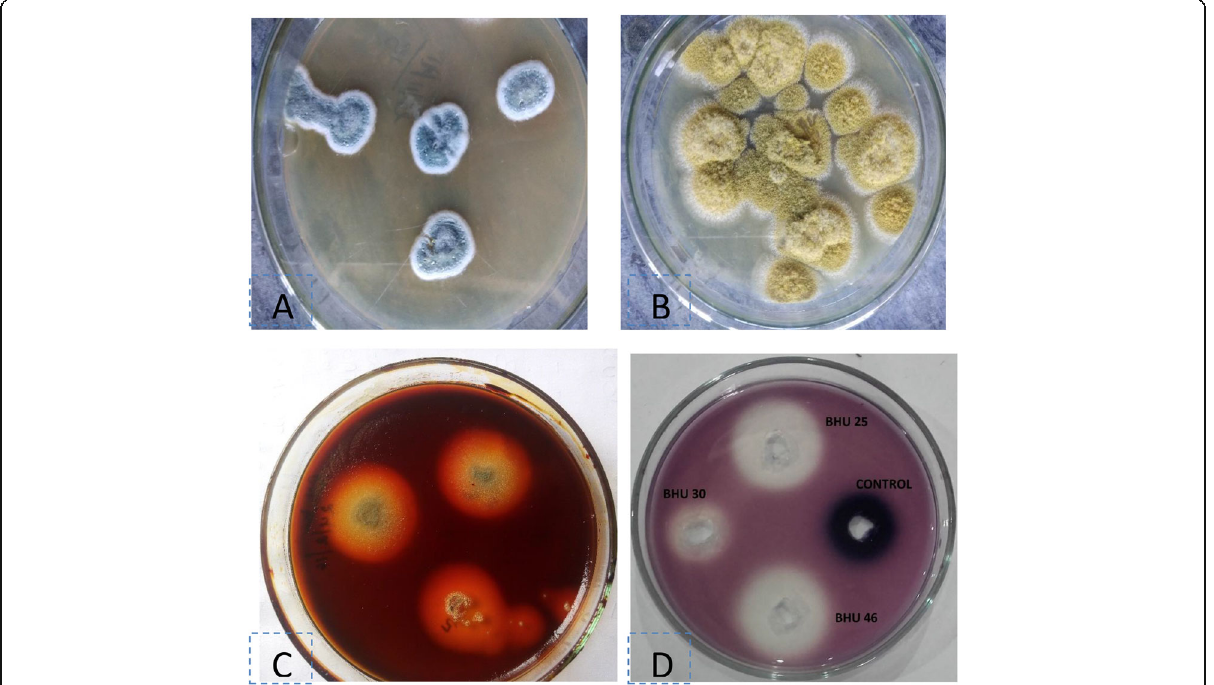
Fig. 3 Colony morphology of isolates a BHU-25-1; b BHU-46, d hydrolysis of pullulan by the isolates BHU-25, and BHU-46 plate flooded with